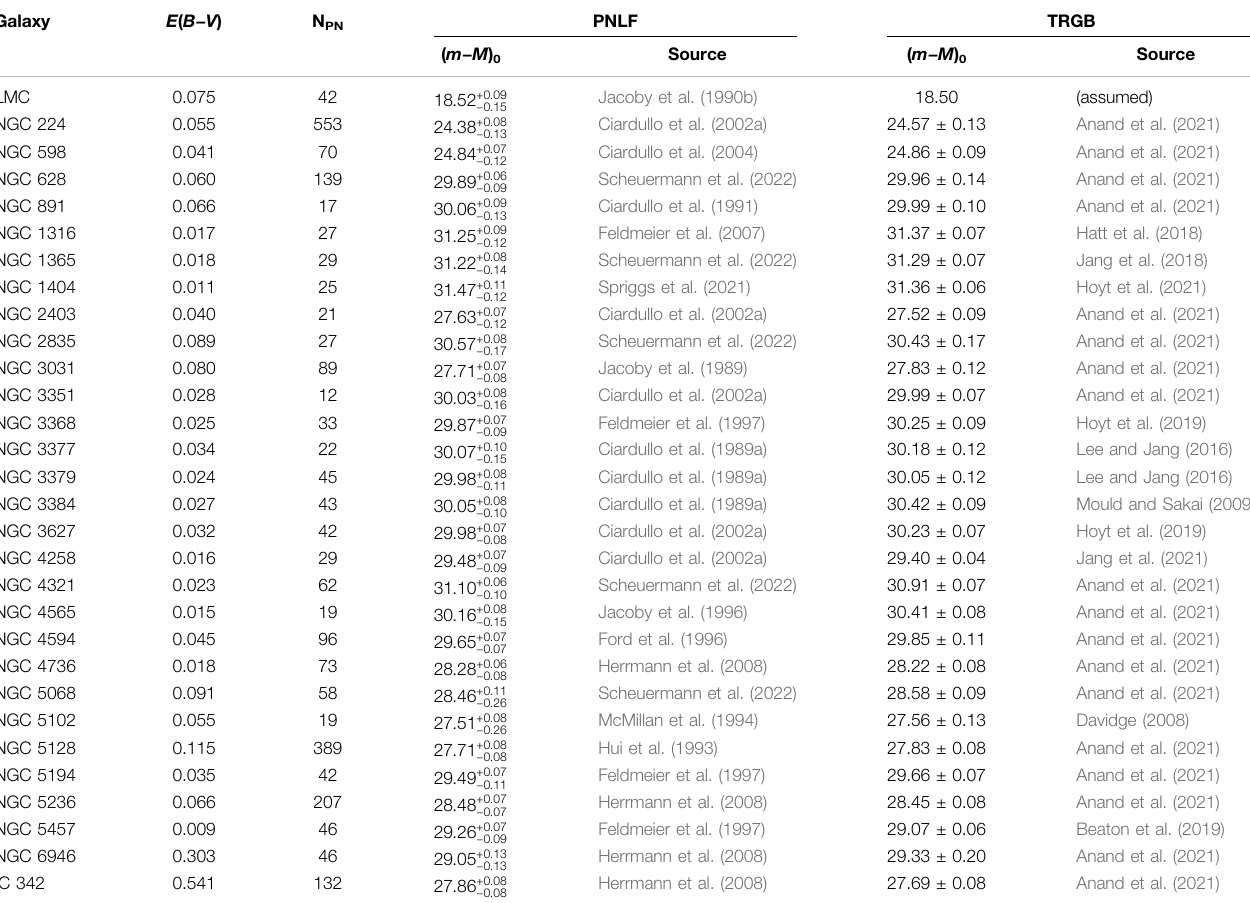
TABLE 2 | Galaxies with TRGB